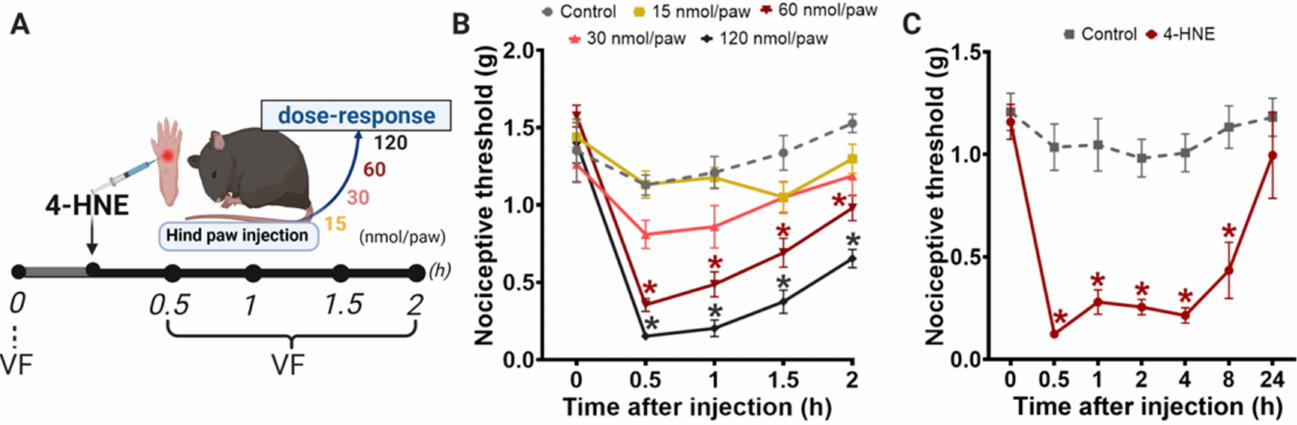
Figure 1. Dose-response curve and time course of 4-HNE-induced mechanical hypersensitivity. ( A ) Schematic panel of pain threshold assessment by von Frey filament test (VF) and the treatment protocol. ( B ) 4-HNE was injected intraplantarly (15, 30, 60, and 120 nmol/paw) and the nociceptive threshold was assessed by von Frey filaments, by an “up-down” method. ( C ) Time-course of 4-HNE-induced mechanical hypersensitivity (60 nmol/paw). Error bars represent mean ± SEM; n = 8 per condition. * p < 0.05 when compared with the baseline measure (time 0). Two-way analyses of variance (ANOVA) with post-hoc testing by Tukey. The observer was blinded to the experimental